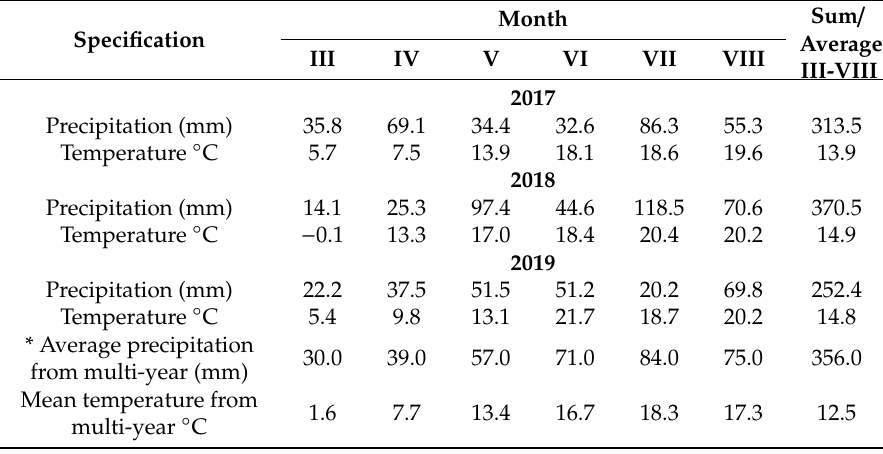
Table 1. Course of weather conditions during the vegetation periods.